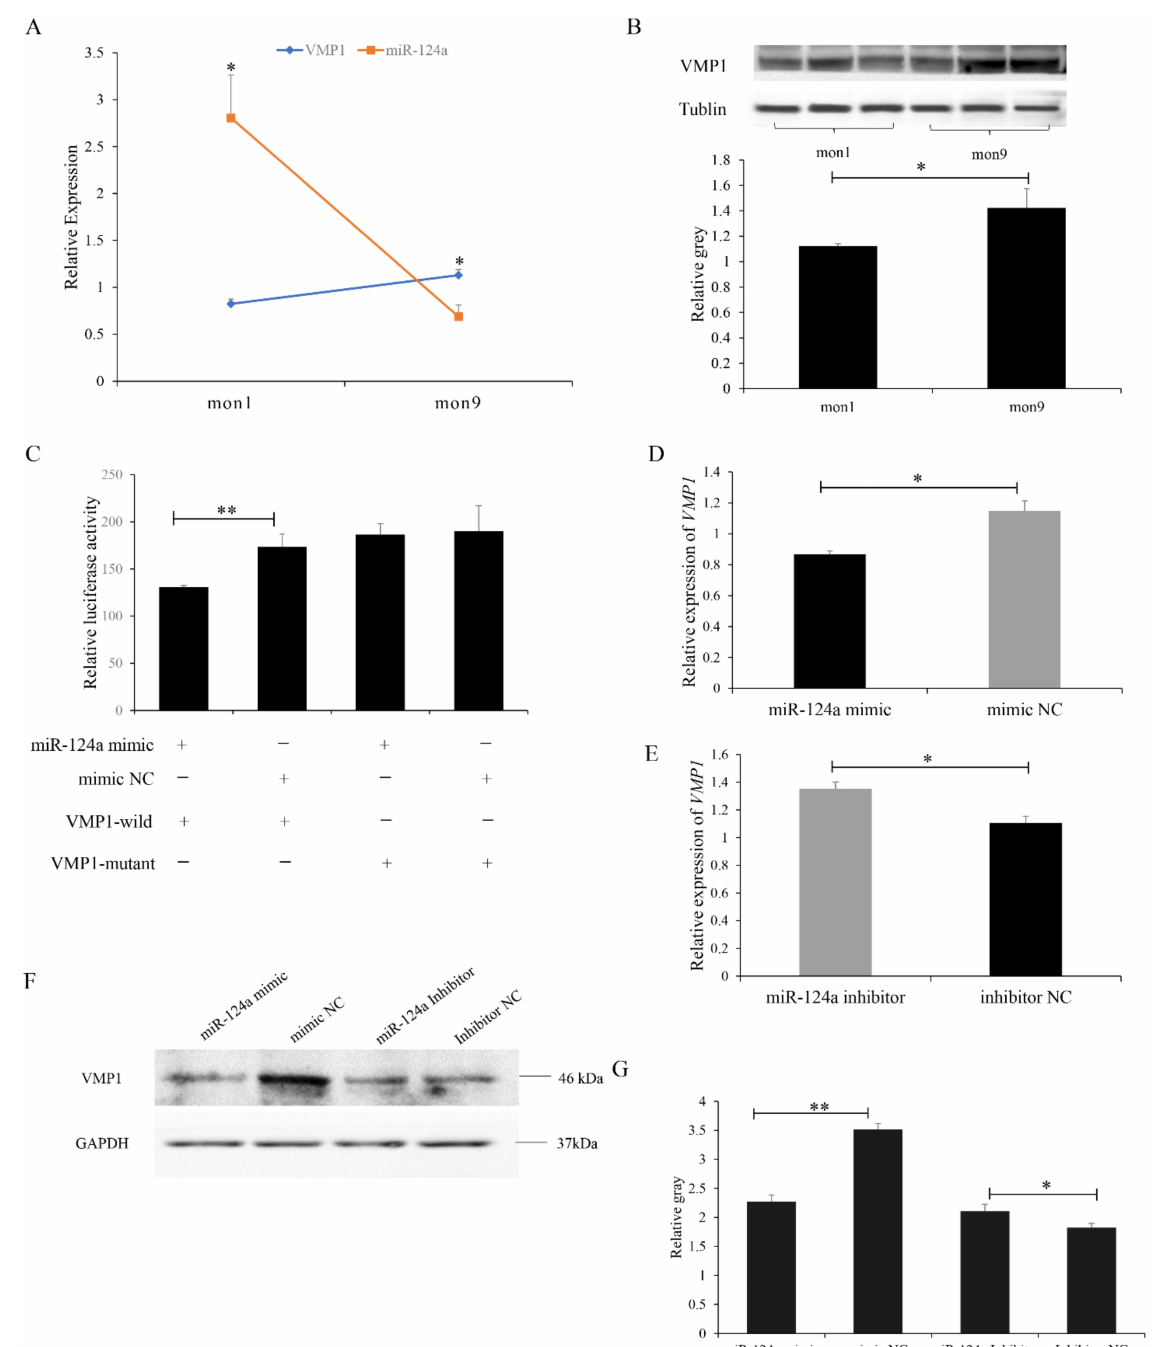
Figure 5. Expression of miR-124a and its regulation of VMP1 in goat LD tissue: ( A ) Expression levels of miR-124a and VMP1 in mon1 and mon9 goat LD tissues. Data are presented as means ± standard error (SE); n = 3. ( B ) Western blot of VMP1 levels in the LD tissues is consistent with mRNA expression. ( C ) Relative luciferase activity was assayed 48 h after 293T cells were co-transfected with VMP1-3 (cid:48) -UTR wild-type or mutant dual-luciferase vectors, together with the miR-124a mimic or mimic negative control (NC). ( D , E ) Expression of VMP1 in goat myoblasts was detected by RT- qPCR in cells overexpressing and underexpressing VMP1. ( F , G ) Western blot of VMP1 in goat myoblasts overexpressing and underexpressing miR-124a. Replications = 3. Data are presented as the mean ± SE; * p < 0.05 and ** p <